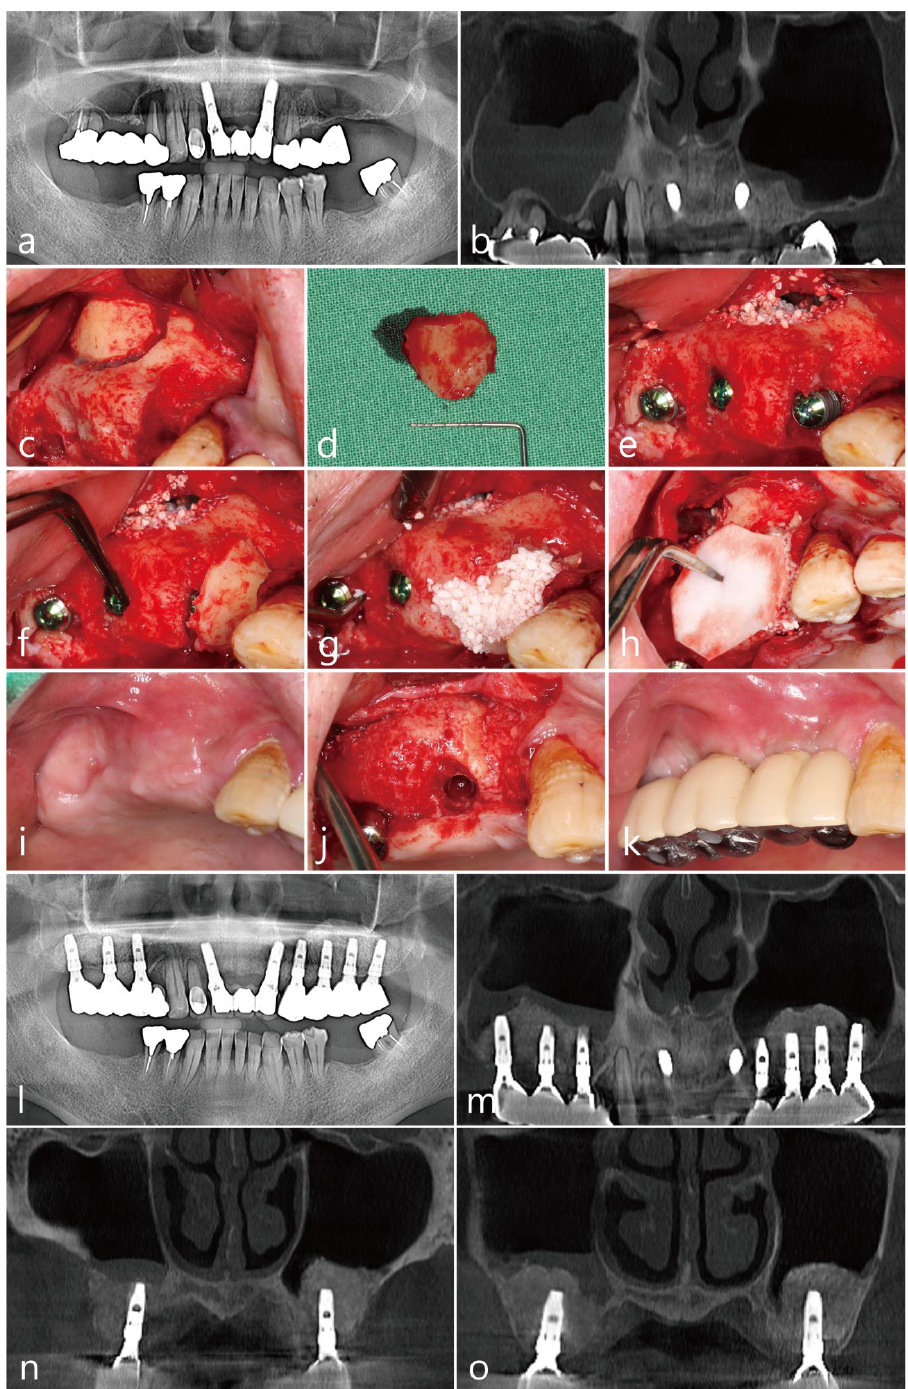
Figure 4. Case 4: ( a ) preoperative panoramic radiograph; ( b ) panoramic image of the preoperative CBCT scan; ( c ) after flap reflection, the lateral bony window was prepared; ( d ) obtained lateral bony window; ( e ) implants were placed after the maxillary sinus augmentation; ( f ) the lateral bony window was cautiously trimmed and placed on the mesial bony defect; ( g ) additionally, particulate bone graft was used to fill the gap; ( h ) a resorbable collagen membrane was placed on the grafted site; ( i ) a clinical view at six months after surgery; ( j ) the grafted lateral bony window was well integrated with the surrounding native bone; ( k ) clinical view after prosthesis delivery; ( l ) panoramic radiograph at six months after prosthesis delivery; ( m ) panoramic image of the CBCT at six months after prosthesis delivery; ( n ) coronal image of the CBCT scan showing posterior superior alveolar arteries on both sides; ( o ) coronal image of the CBCT scan showing reduced mucosal thickening on the right maxillary